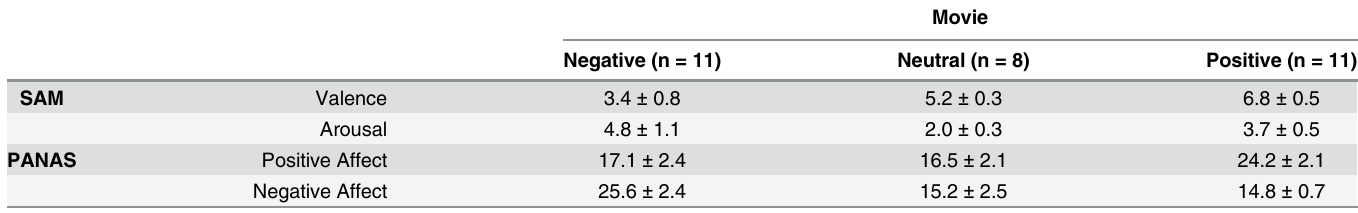
Table 1. Scores of SAM and PANAS subscales for each movie. These scores (mean ± SD) were calculated from those obtained for different video clips constituting each movie. n is the number of video clips for each